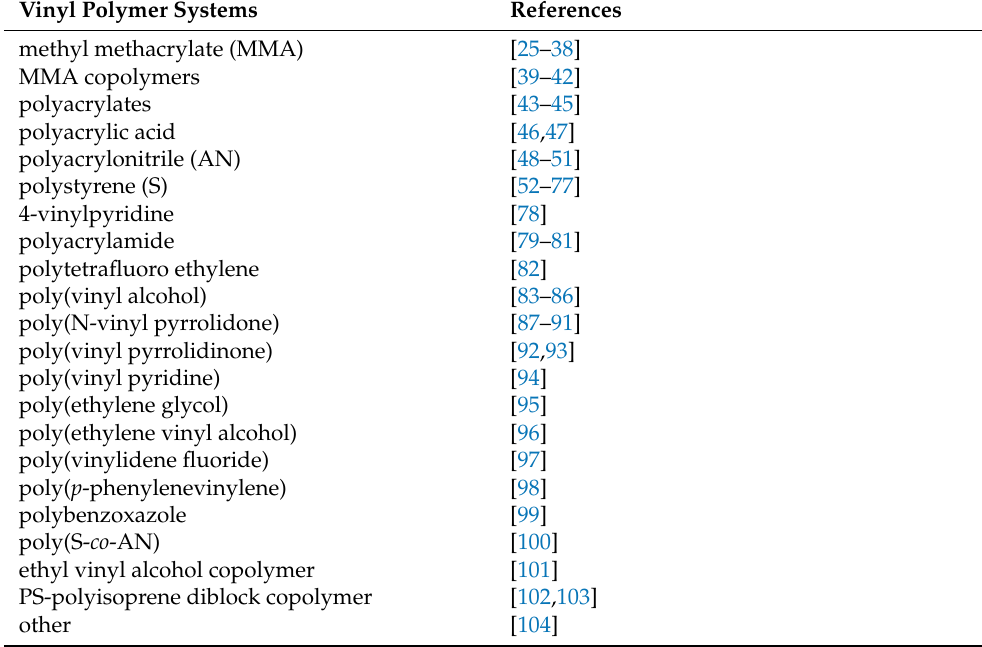
Table 2. Vinyl polymer